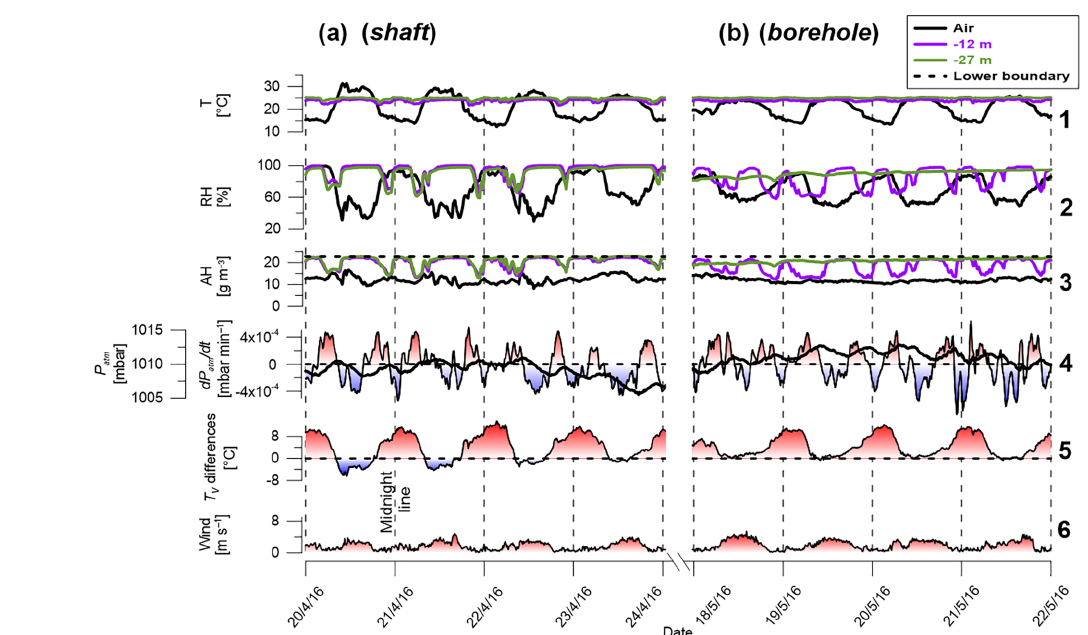
Figure 2. Time series results from four representative days for the shaft (a) and borehole (b) . For simplicity, results from only four continuous days are shown and the complete data from the 42 days of measurements are shown in Fig. S1. Absolute humidity (AH) values were calculated using Eq. (1). The lower boundary (black dashed line in no. 3) was approximated as constant with T = 24 . 7 ◦ C and RH = 100% and for the case of the borehole represents the values at the soil–borehole interface. T v difference values (Eq. 5) represent the T v differences between 12m of depth and the air aboveground. T v values were calculated according to Sánchez-Cañete et al. (2013) using CO 2 concentrations of 2000 and 400ppm for 12m of depth and air aboveground, respectively. The CO 2 value used for 12m was obtained from 2 weeks of measurements within the borehole during the winter of 2017, during which the CO 2 did not exceed